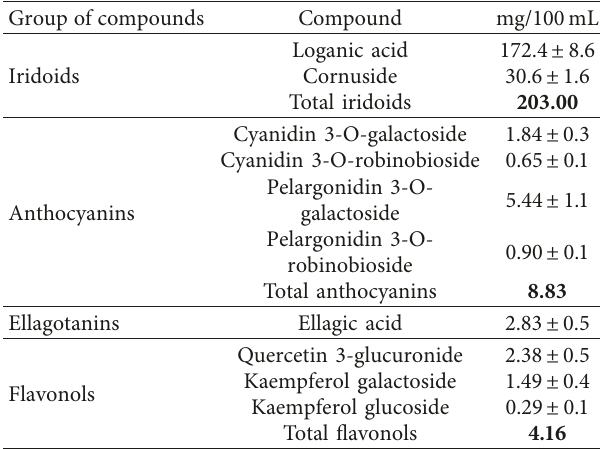
Table 2: Data of active compounds of cornelian cherry juice, n �